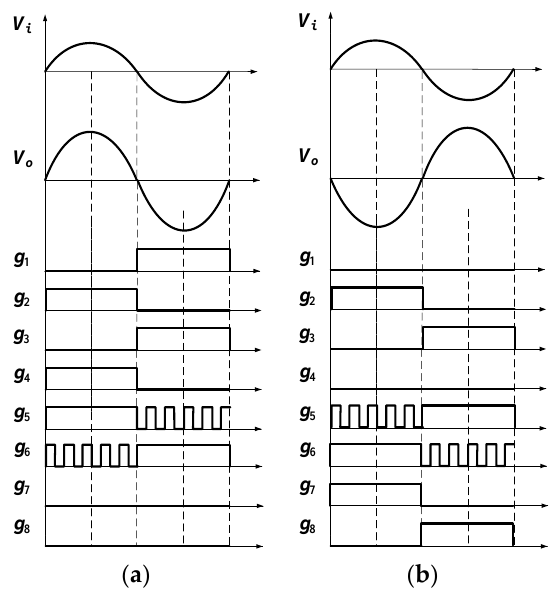
Figure 4. Gating sequences: ( a ) boost operation for positive voltage gain; ( b ) boost operation for negative voltage gain.